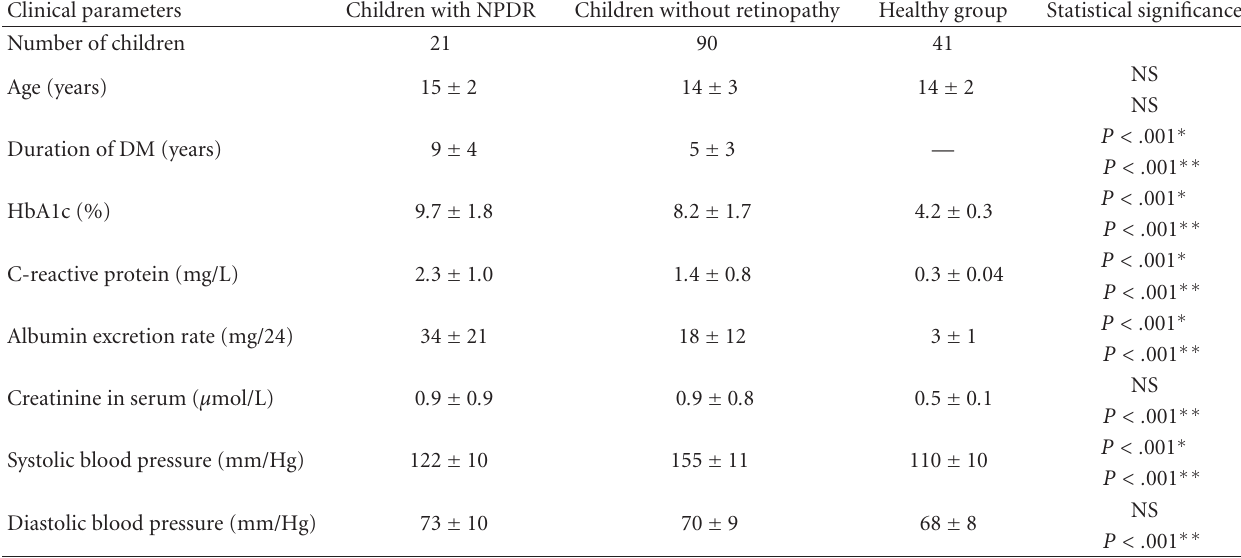
Table 1: Clinical parameters of the DM type 1 children and healthy group. Values are presented as means ± SD. Clinical parameters